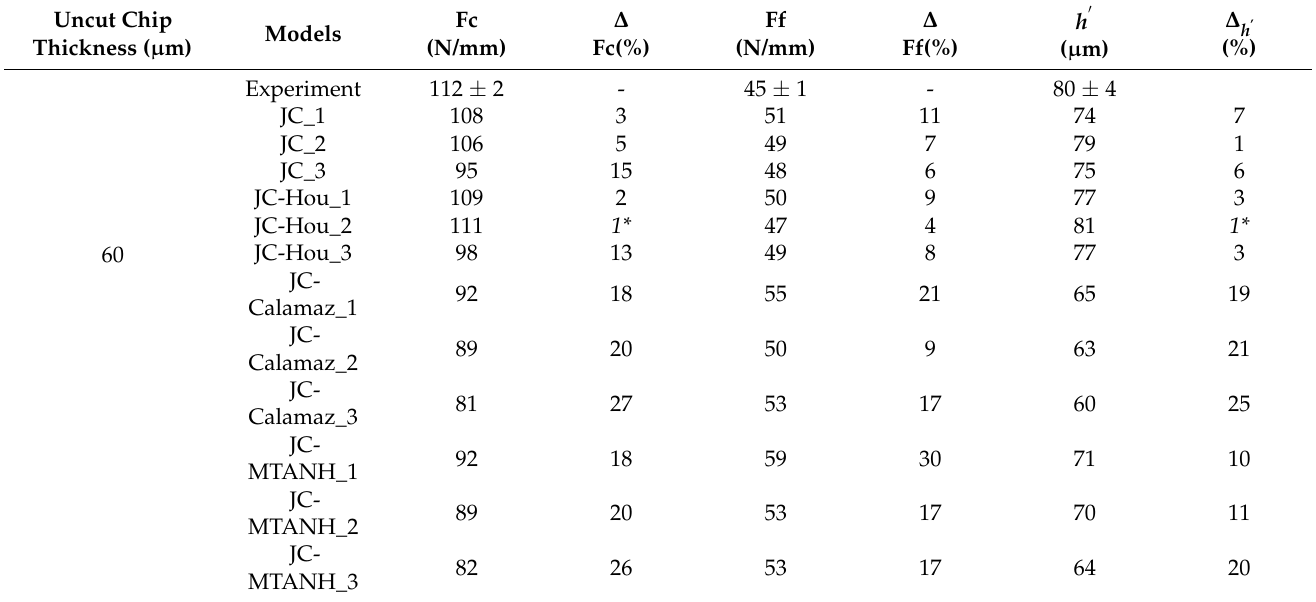
Table 7. RMS cutting force (Fc), feed force (Ff), chip thickness ( h (cid:48) ) and ∆ x differences with the experimental forces of h = 60 µ m. Uncut